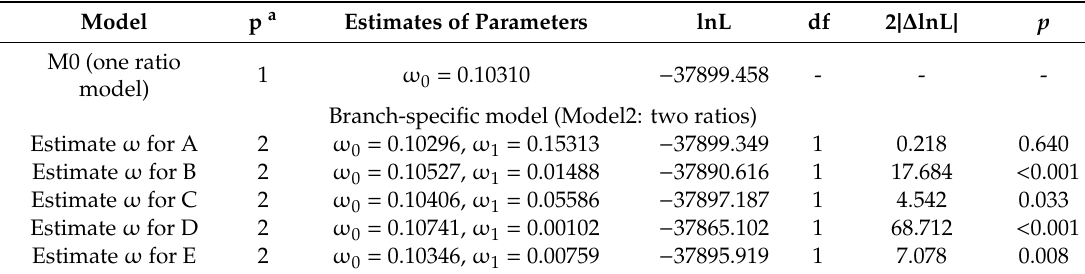
Table 2. Parameter estimates and likelihood ratio tests for the branch models.